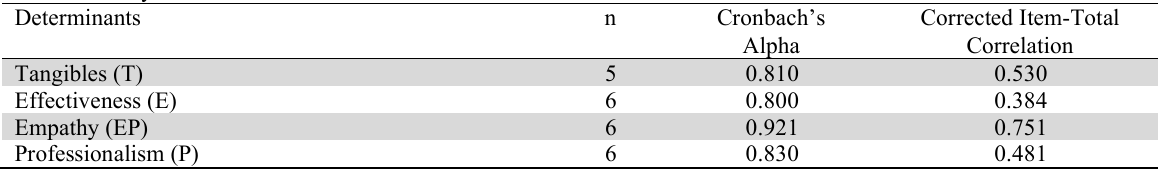
Corrected Item-Total Alpha Correlation